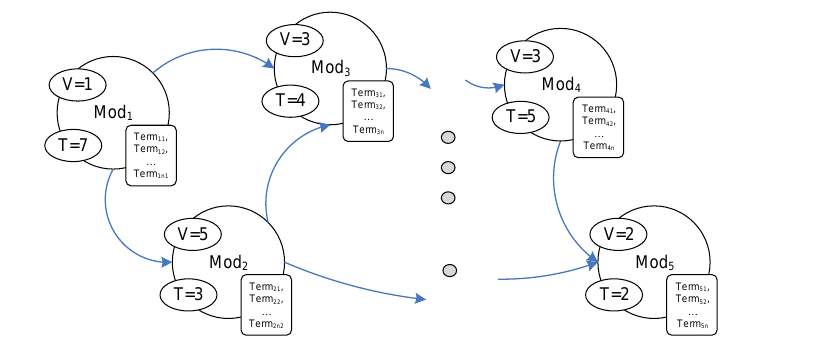
Fig. 3. A digraph of a network plan for studying modules in a language of